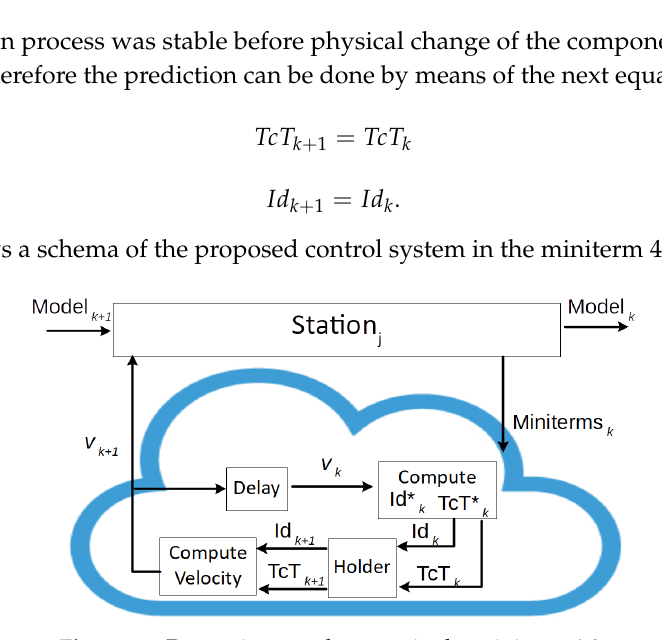
Figure 13. Dynamic control system in the miniterm 4.0.